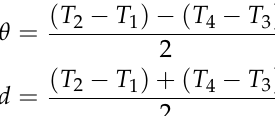
Figure 14. MAC layer timestamping with a IEEE 802.15.4-2006 compliant transmitter and receiver